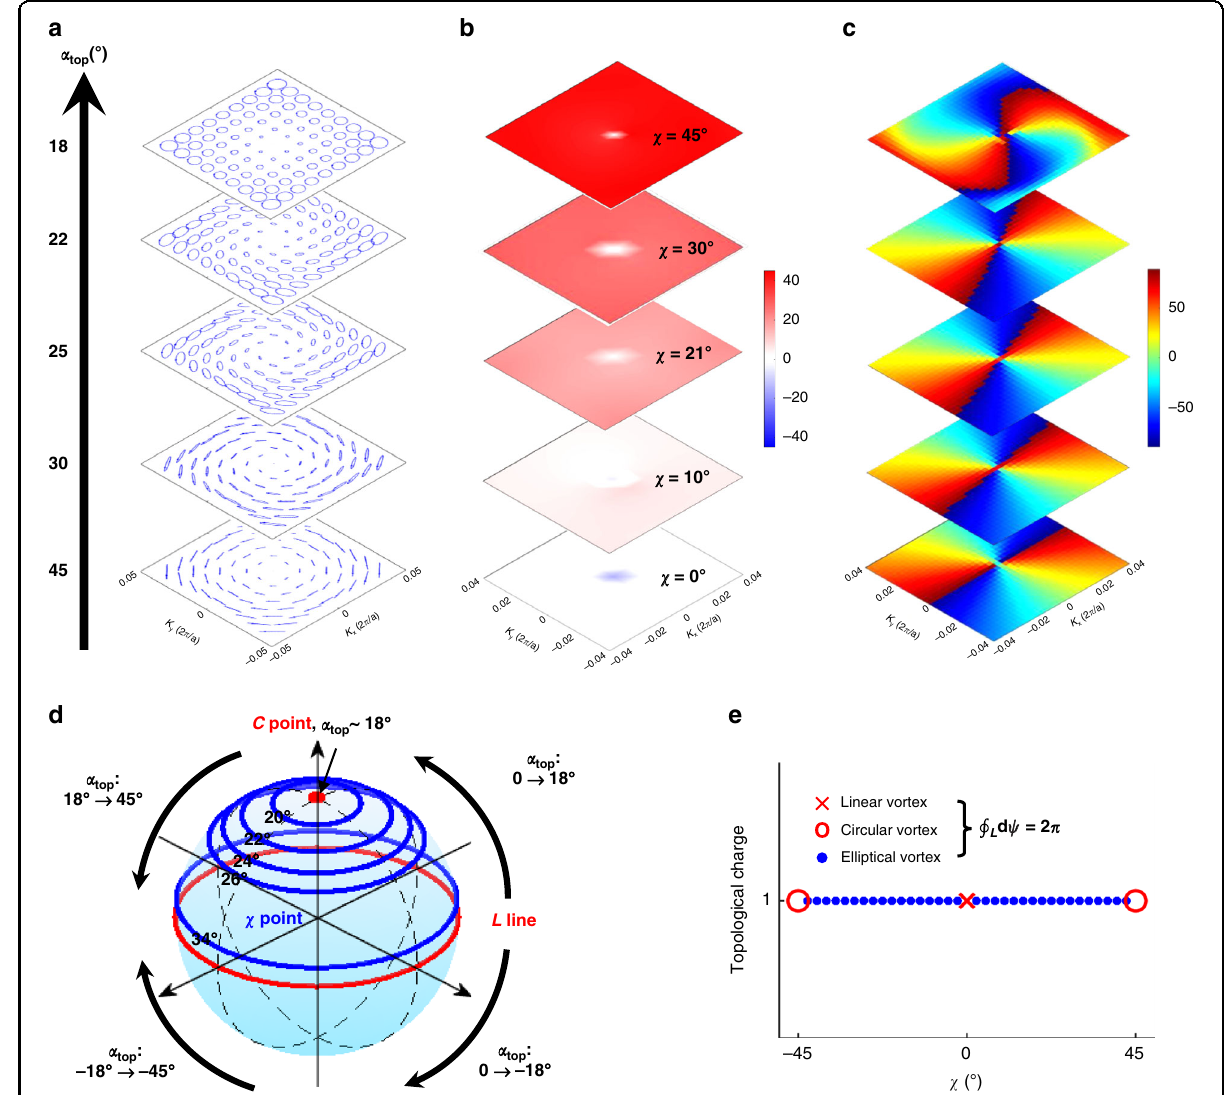
Fig. 6 Evolution of far- fi eld polarization states in the upward with varying rotation angle α top of the top hole in the twisted PhCS. a Polarization ellipses evolve from linear state with α top = 45°, elliptical state with α top = 45°~18°, to circular state with α top = 18°. b The corresponding values of χ show uniform ellipticity in vicinity of each BIC. c The orientation angle ψ changes from − 90° to 90° twice demonstrating BIC topology. d Poincaré sphere illustrates the evolution of polarization states around BIC. At every α top , the polarization distribution matches a parallel on the sphere, in accord with different χ . Full coverage of Poincaré sphere can be achieved by changing α top . e The topological charge maintains 1 for vortex with different